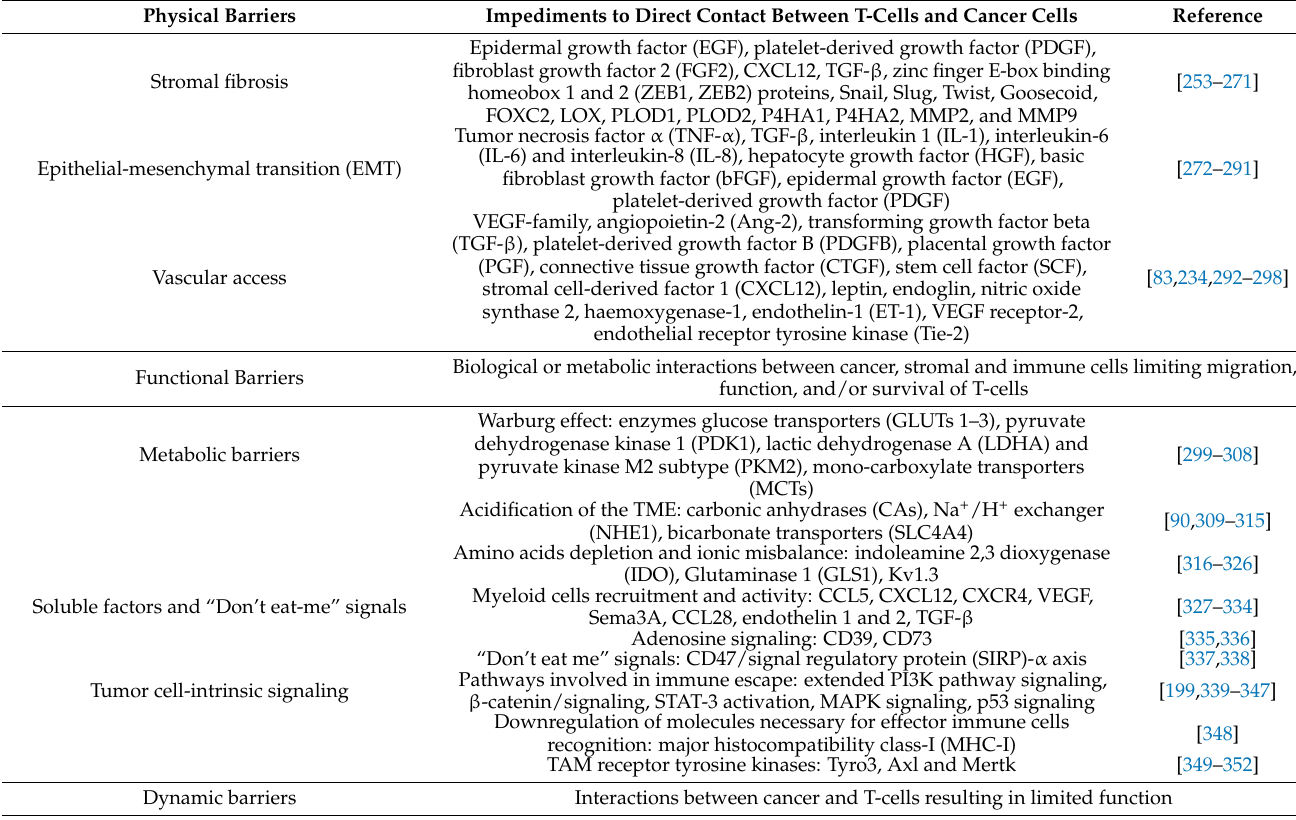
Table 2. Determinants of immune exclusion that are influenced by